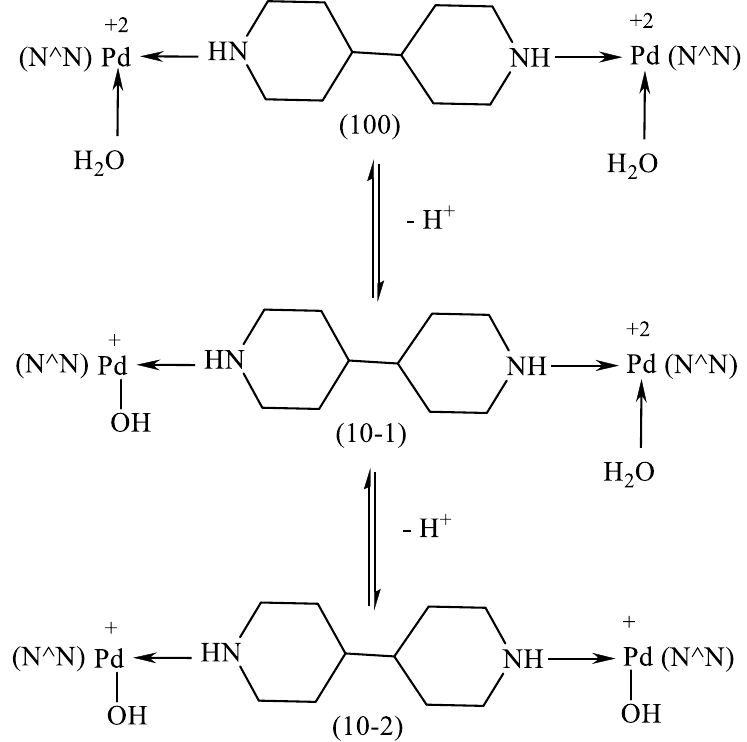
plexes, as described in Scheme 7. The formation constant values for the BHEP system are